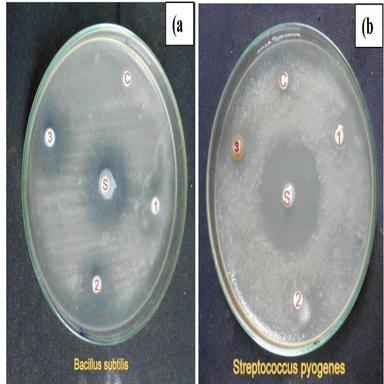
Antibacterial activity of SnO2 and CdO-SnO2 nanocomposite material (a) Bacillus subtilis and (b) Streptococcus pyogenes.